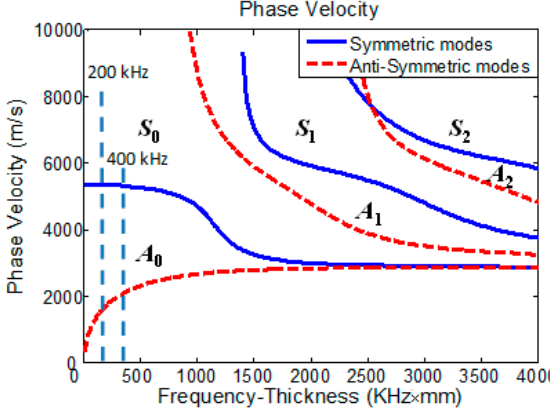
Figure 1. Dispersion curves of Lamb waves in an aluminum plate: phase velocity.